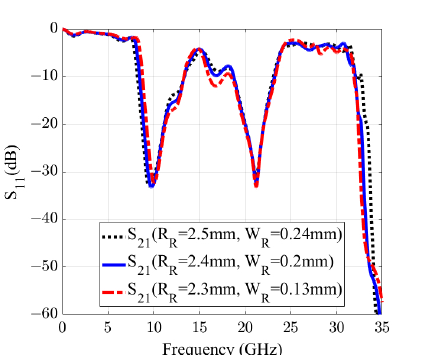
Figure 7. Scattering parameters of the filter and the independent movement of the first resonance by different value of the width and the radius of the resonators. The first resonance mode can be independently controlled within the frequency band from 9.4 to 10.1 GHz.